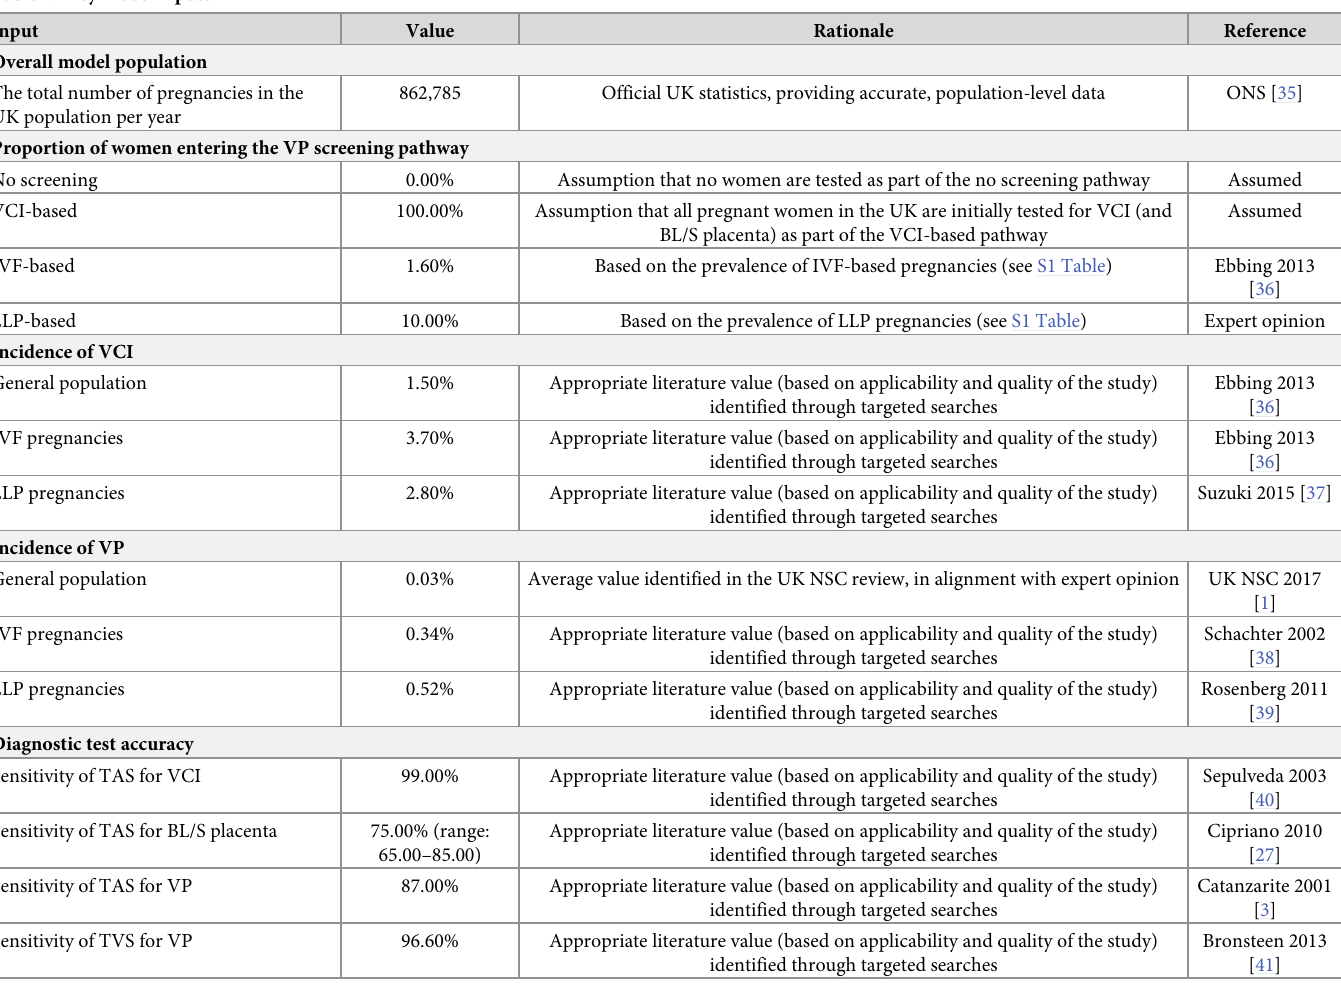
Table 2. Key model